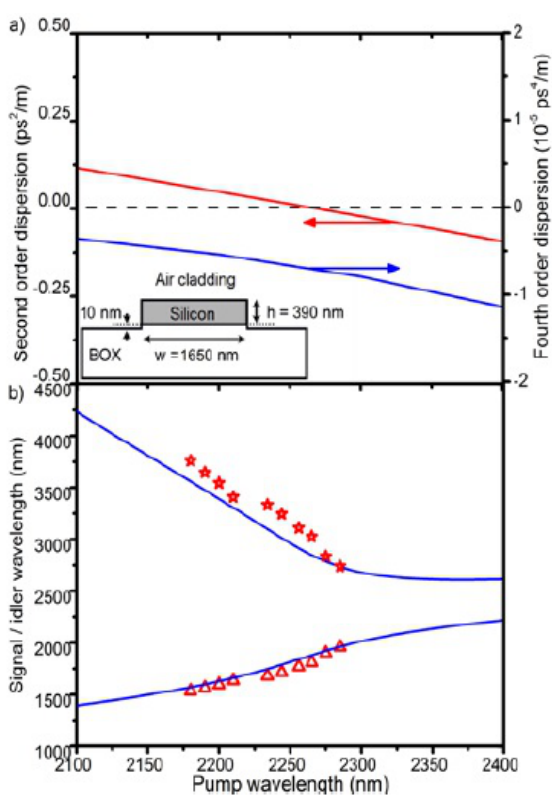
Fig. 18. (a) The simulated second and fourth order dispersion of the silicon waveguide shown in the inset. (b) The phase-matched signal (triangles) and idler (stars) wavelengths as a function of the pump wavelength for this waveguide. The blue line is the theoreti- cal prediction of phase-matched idler and signal pairs as a function of pump wavelength. Adapted from reference [65].